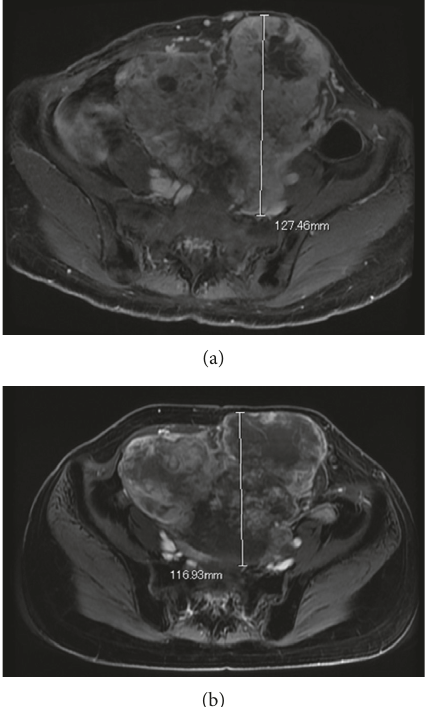
Figure 3: Magnetic resonance imaging findings (T1-weighted fat suppression gadolinium-enhanced image). (a) After four courses of IFM/DXR. (b) After 31 months of pazopanib administration. It was classified as no change by the RECIST criteria; however, slight tumor reduction and a decrease of enhancement were observed after 31 months of pazopanib